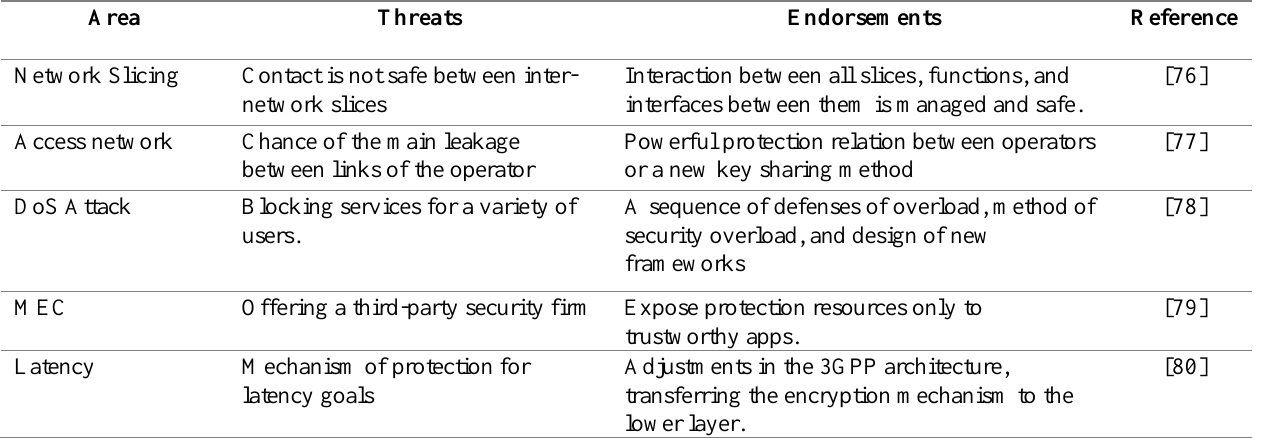
Table 2. Next Generation Mobile Networks Alliance (NGMN) risks and